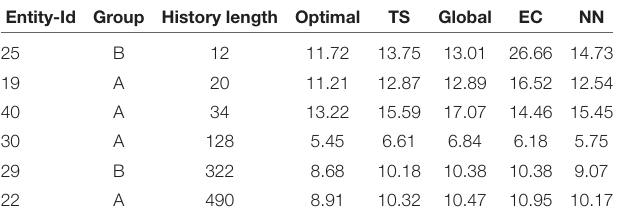
TABLE 7 | Combined average error for each item across all the time steps for the complete bandit using optimal and Thompson sampling strategies to that of its